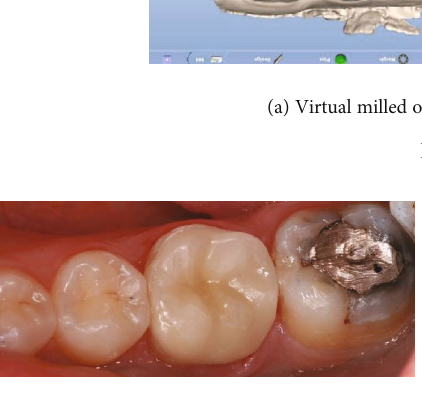
Figure 8: Final outcome after